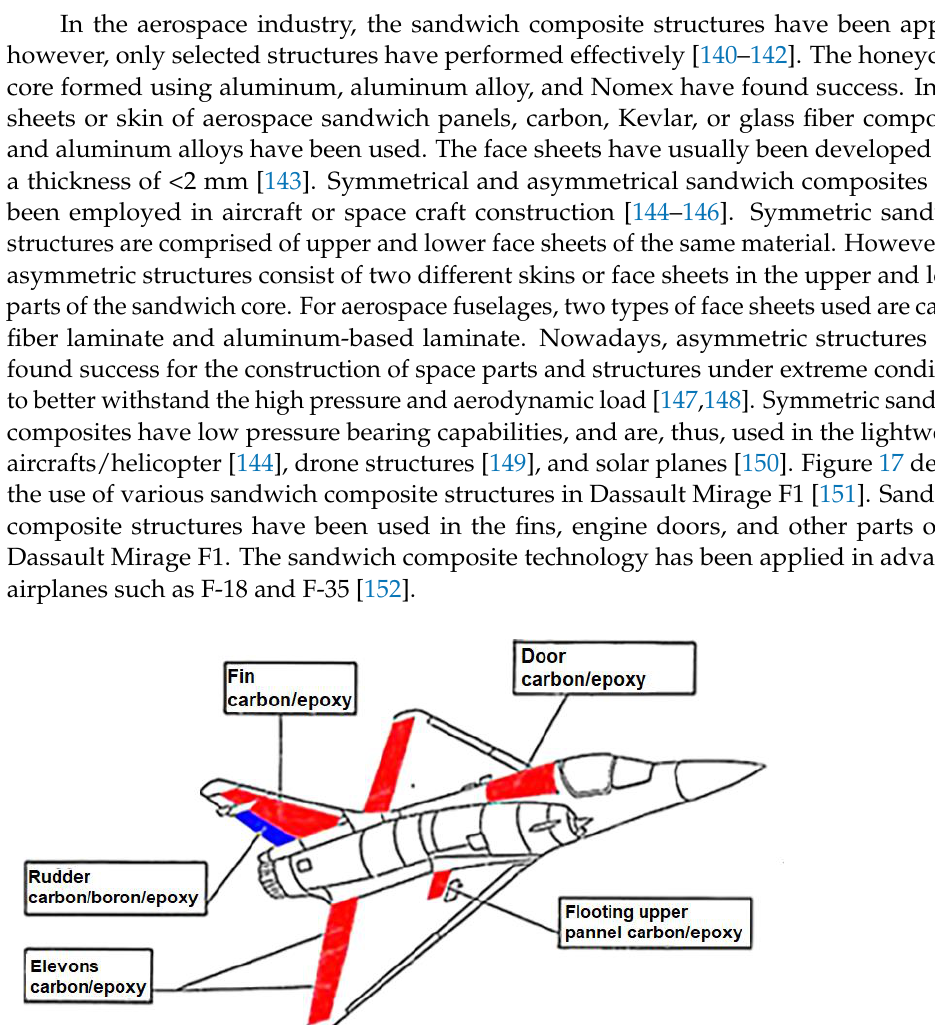
Figure 18. F-35 aircraft ( a ) flow analysis and ( b ) cross section of sandwich composite and principal strain on sandwich composite of glass fiber reinforced plastics (GFRP) with a poly(vinyl chloride) core [152]. Reproduced with permission from Springer. 5.2. Automotive The automotive industry has explored various novel structures and manufacturing processes for lightweight and enhanced performance of the vehicles [154]. The sandwich composite structures have been adopted to replace the conventional metallic materials like aluminum and steel [155]. For automobiles, the sandwich structures have high